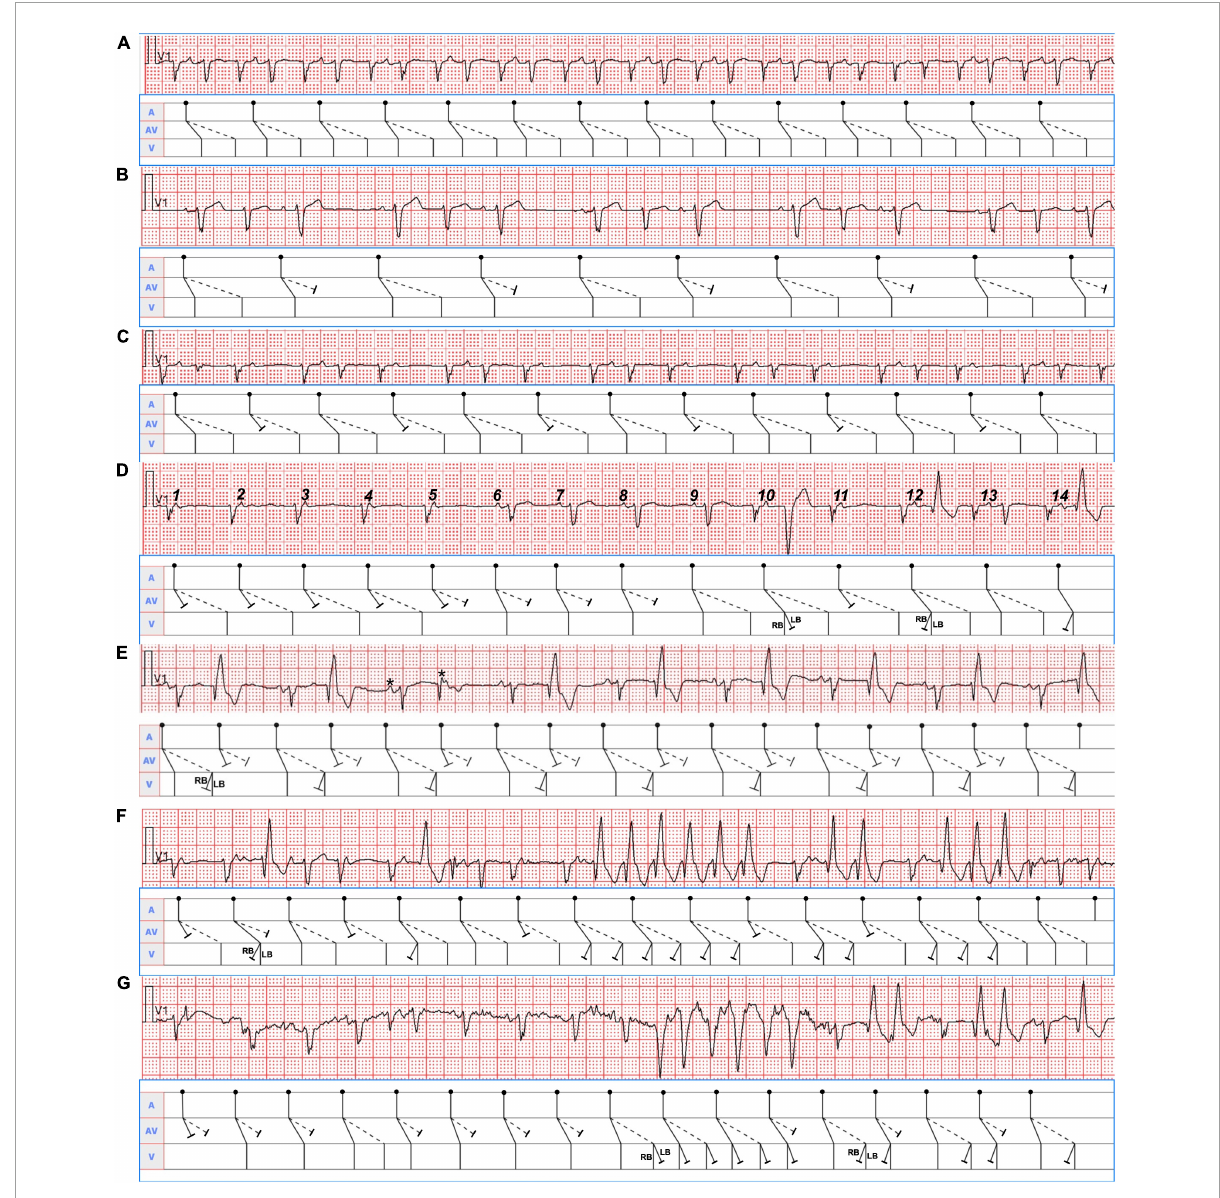
FIGURE3 Seven typical Holter recording strips in lead V 1 were shown. The corresponding mechanism was explained in the ladder diagram below each of them. RB, right bundle; LB, left bundle. (A) The sinus P waves (PP intervals 740 msec) were conducted simultaneously over the dual AV nodal pathways, producing a double ventricular response. (B) Group beatings with PP intervals of 1,120 msec were presented. A group of three was seen throughout the tracing follow by a pause, suggesting sinus beats conducted with alternating 1:2 and 1:1 AV ratios with longer PR intervals (160 msec) during 1:1 conduction over the fast pathways. (C) The sinus beats (PP intervals 820 msec) in the group beatings conducted with alternating 1:1 and 1:2 AV ratios with shorter PR intervals (580 msec) during 1:1 conduction over the slow pathways. (D) The front 5 and eleventh P waves were conducted only through the slow pathways, then the sixth to eighth P waves only via the fast pathways, and the ninth, tenth, twelfth, and thirteenth P waves simultaneously over the dual AV pathways. The tenth P wave with a PR interval of 240 msec gave rise to a QRS complex with left bundle branch block (LBBB) morphology, whereas the twelfth and fourteenth P waves with a PR interval of 220 msec produced a QRS wave with right bundle block (RBBB) pattern. The front 7 PP intervals were 720 msec, whereas the remaining PP intervals were approximately 840 msec. (E) The remaining adjacent PP intervals will be determined according to the PP interval of 600 msec consisting of two P waves marked with asterisks. The 2:1 conduction block occurred when the sinus beats were conducted simultaneously via the fast and slow pathways. Additionally, RBBB aberrancy except the sixth QRS complex were presented with conduction through the slow pathways. (F) Single, double, triple, and especially six consecutive QRS complexes with RBBB configuration from the conduction via the fast and slow pathways were shown in the lead V 1 rhythm strip. It was the most difficult to identify them due to the superimposition of the P waves (PP intervals 640 msec) on the QRS complexes. (G) As a result of the conduction via the fast and (or) slow pathways, single and double QRS complexes with RBBB pattern as well as six consecutive QRS complexes with LBBB morphology coexisted in the lead V 1 rhythm strip. Likewise, the P waves with PP intervals of 620 msec were superimposed on the QRS complexes when LBBB or RBBB occurred, which made them